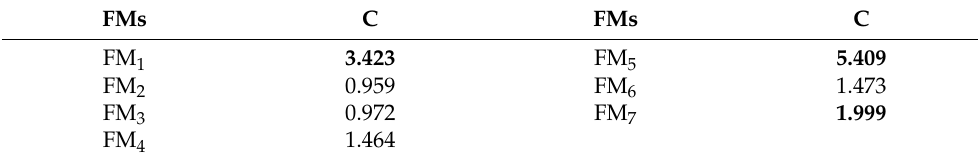
Table 14. Values of C for